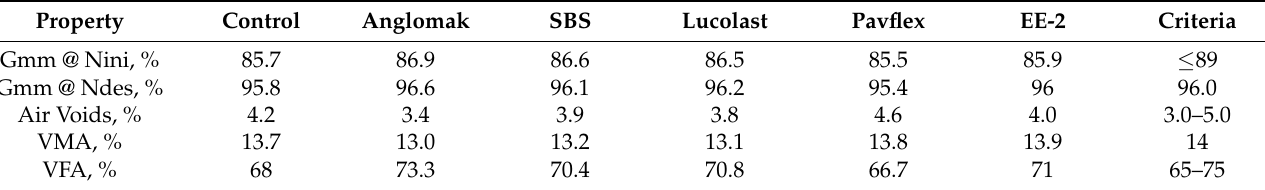
Table 7. Volumetric properties for neat and PMA